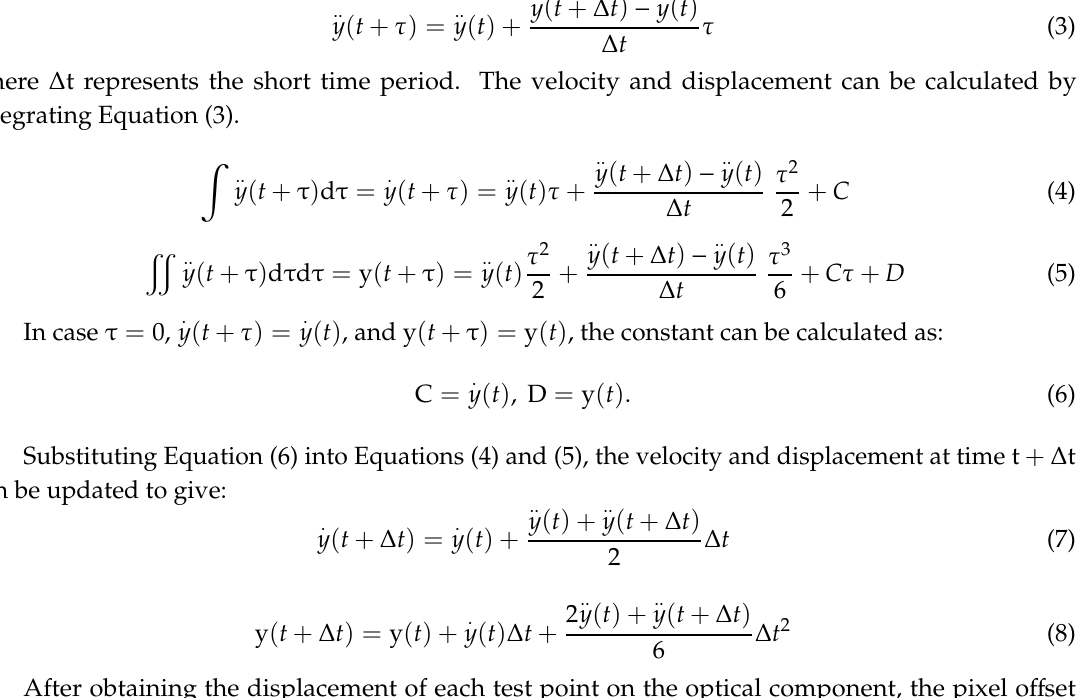
Figure 11. Image of the narrow line target taken by the camera.